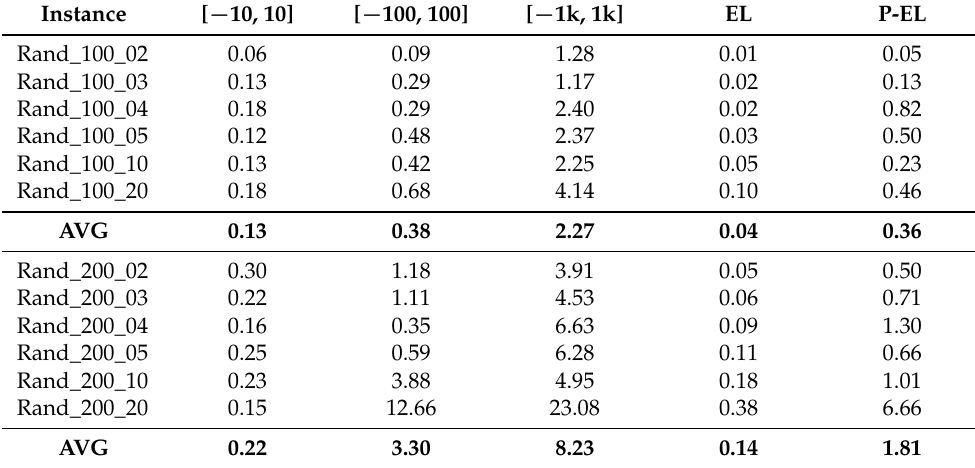
Table 4. Running times for the random